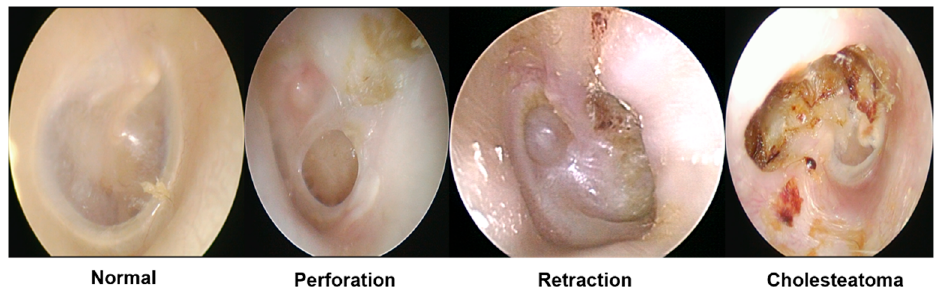
Figure 2. Original image before applying adaptive histogram equalization. Histogram equalization (HE) achieves image equalization using a single histogram.